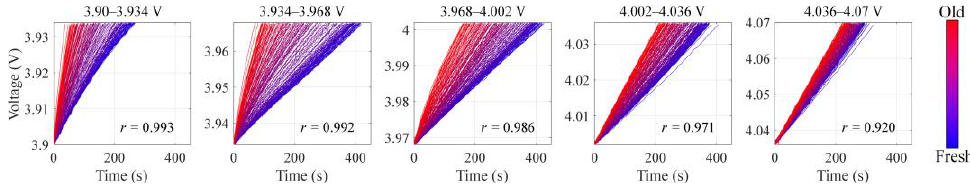
Figure 6. Variation of voltage curves in different sections of NASA.